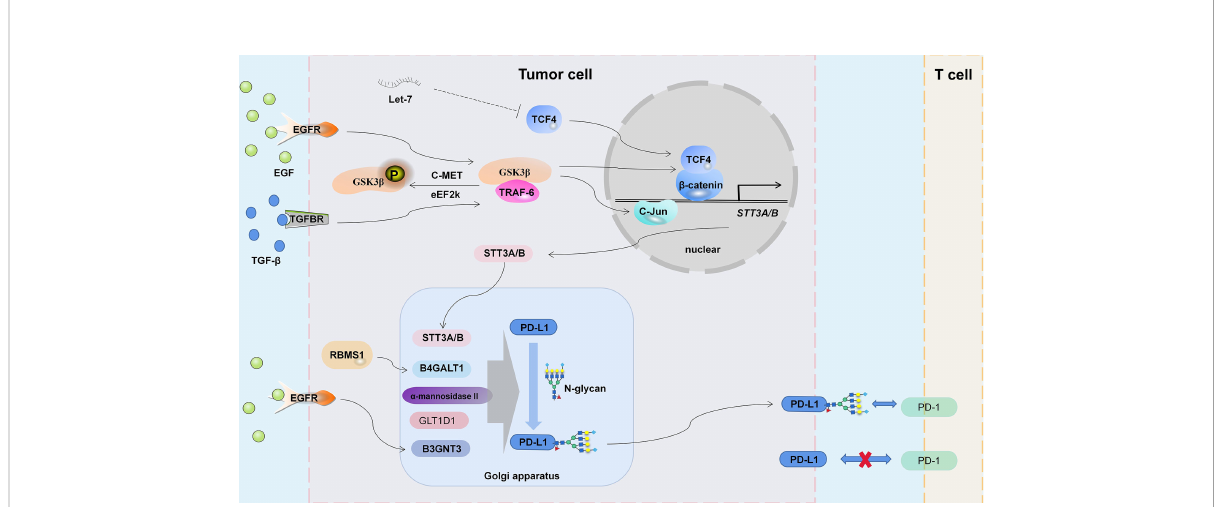
FIGURE 1 The mechanism of PD-L1 glycosylation. EGFR, TGF- b Signaling and noncoding RNA Let-7 participate in the regulation of STT3A/B expression by C-Jun and TCF4/ b -catenin complex. Glycosyltransferases STT3A/B, B4GALT1, a -Mannosidase II, GLT1D1 and B3GNT3 regulate the glycosylation abundance of PD-L1, thus changing the tumor immune